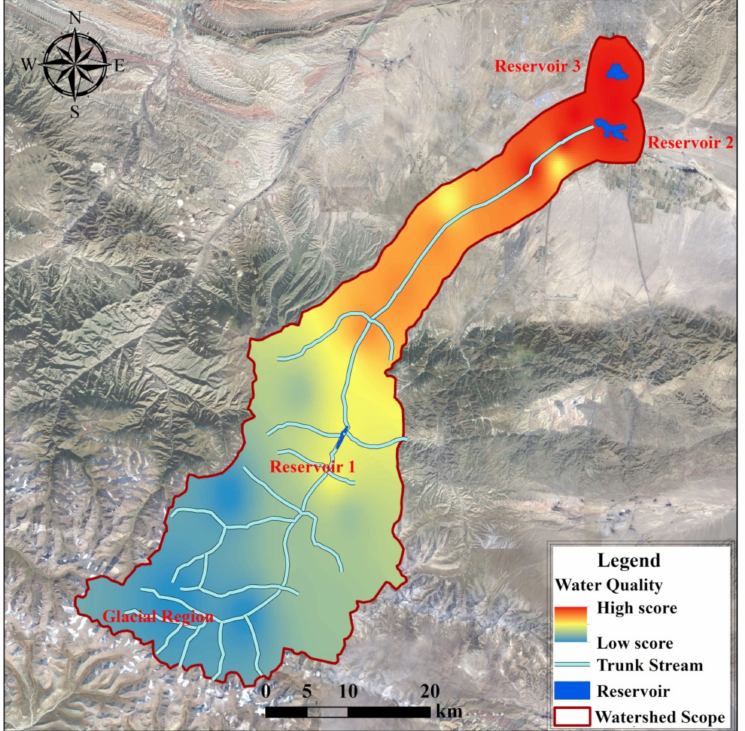
Figure 8. Comprehensive evaluation results of water quality in the study area in 2014 (the lower the score, the better the water